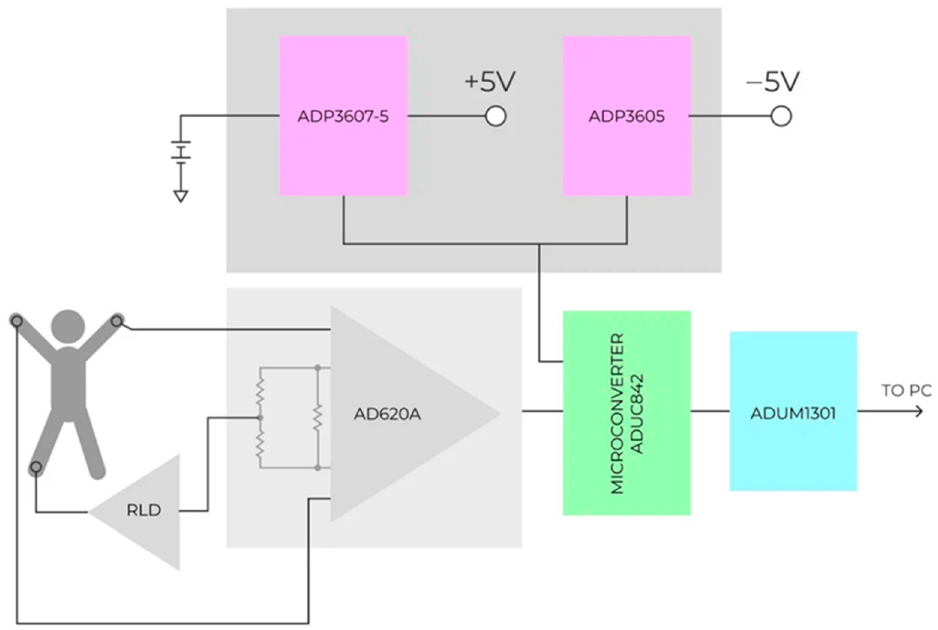
Figure 8. ECG registration devise based on AD620 INA and ADUC842 microconverters. Simplified schematic revised from [52].